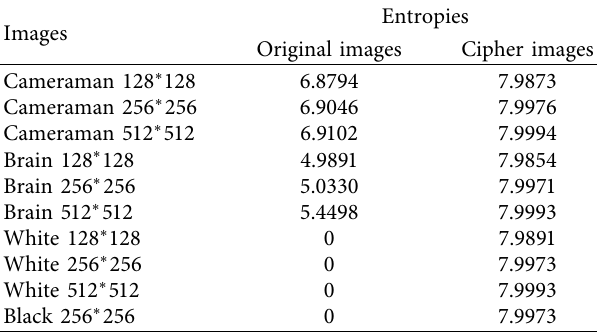
Table 5: Chi-square distribution of histograms with size 256 × 256. Images